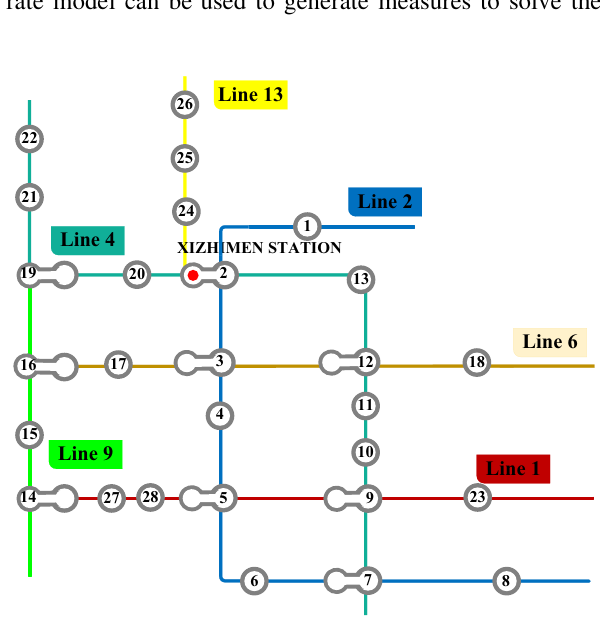
Fig. 3 A part of Beijing metro